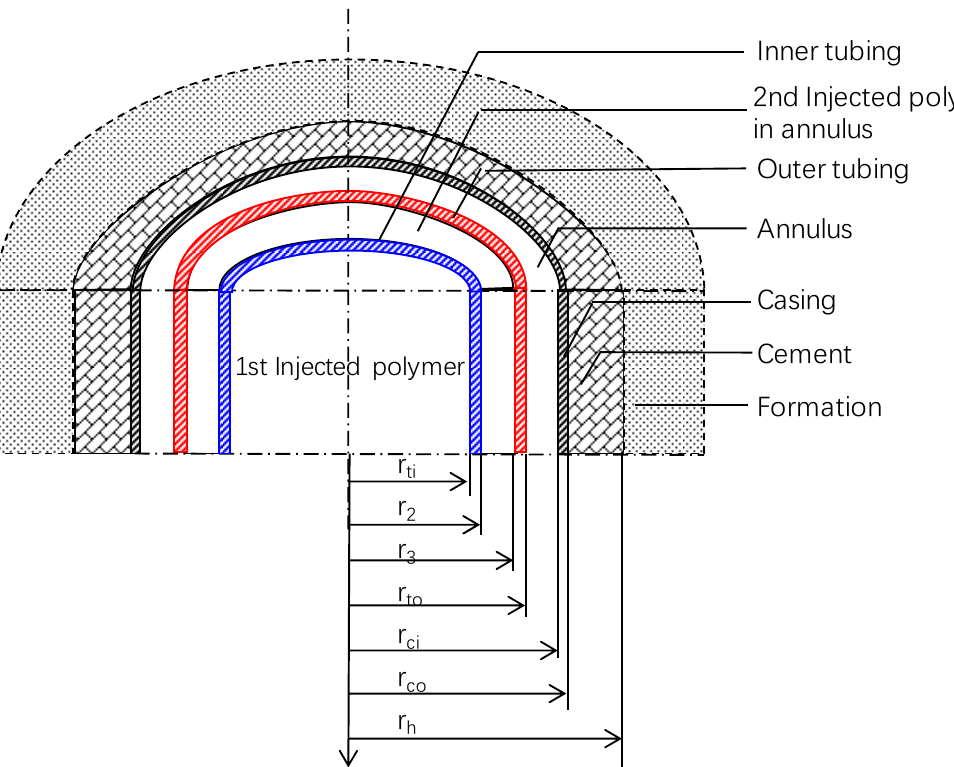
Figure 4. Schematic diagram for separate layer polymer injection well by concentric tubing.